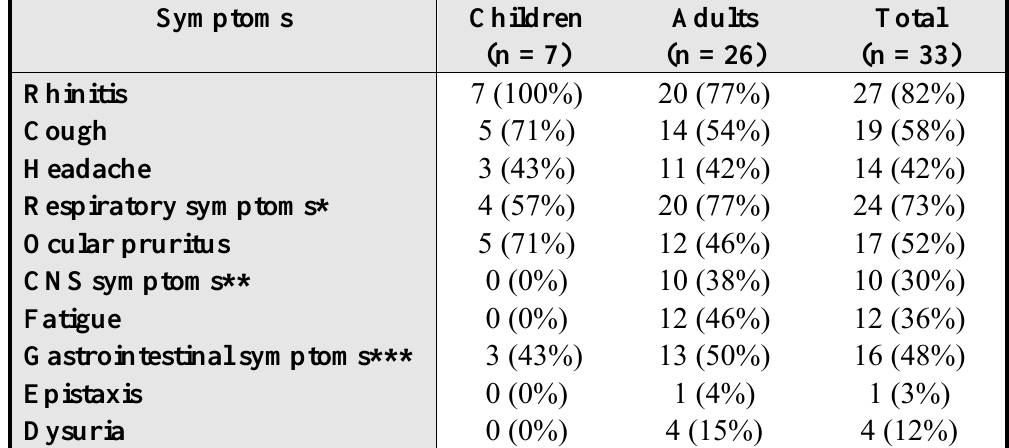
Table 2. Common Presenting Symptoms of Patients with Mold